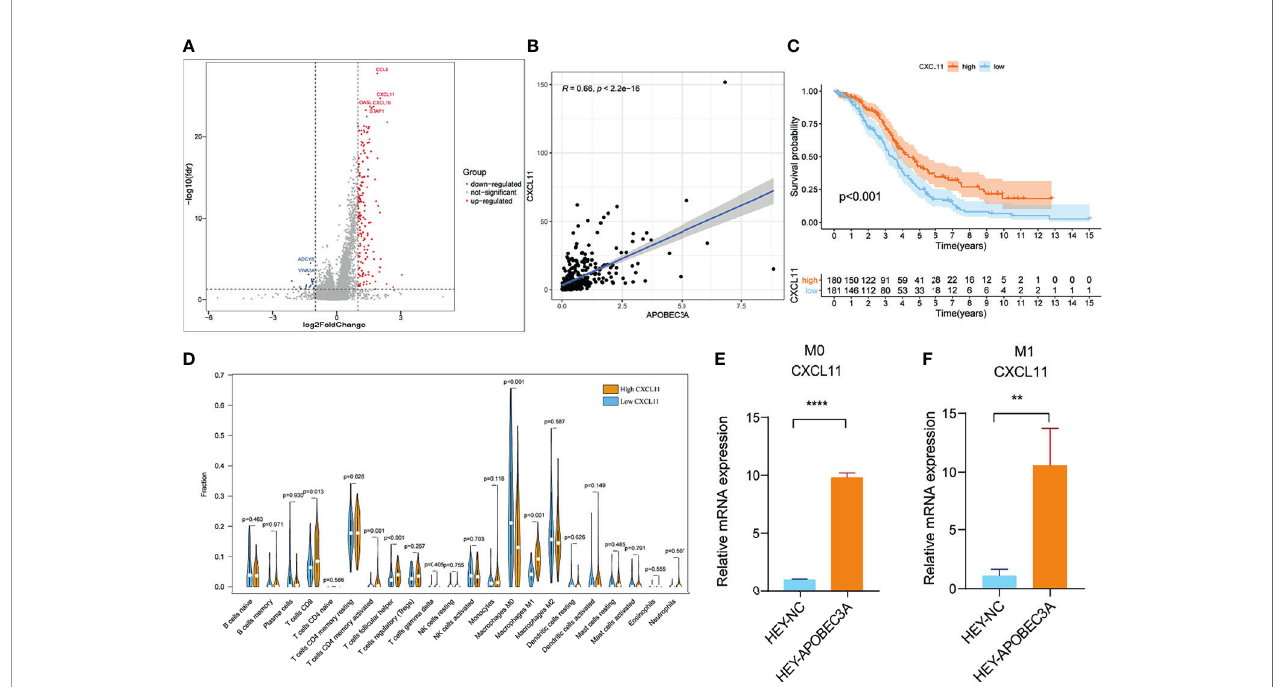
FIGURE 5 | Analyses of APOBEC3A high- and low-expression cohorts in ovarian cancer (OC) patients. (A) Volcano plot for differentially expressed genes (DEGs). The blue and red dots represented the signi fi cantly downregulated and upregulated genes, respectively, and the gray dots represented the genes without differential expression. FDR < 0.05,|log2 FC|> 1, and p < 0.05. (B) The correlation analysis of APOBEC3A expression with CXCL11 expression. (C) Kaplan – Meier curve shows the independent relevance between overall survival time and CXCL11 expression. (D) Violin plot showed the ratio differentiation of 22 types of immune cells between OC tumor samples with high or low expression relative to the median of CXCL11 expression, and Wilcoxon rank sum was applied for the signi fi cance test. (E, F) RT- qPCR showed that APOBEC3A was positively correlated with CXCL11 in Macrophage M0 (E) and M1 (F) . All ** p < 0.01, **** p < 0.0001; the data represent the mean ± SD from triplicate